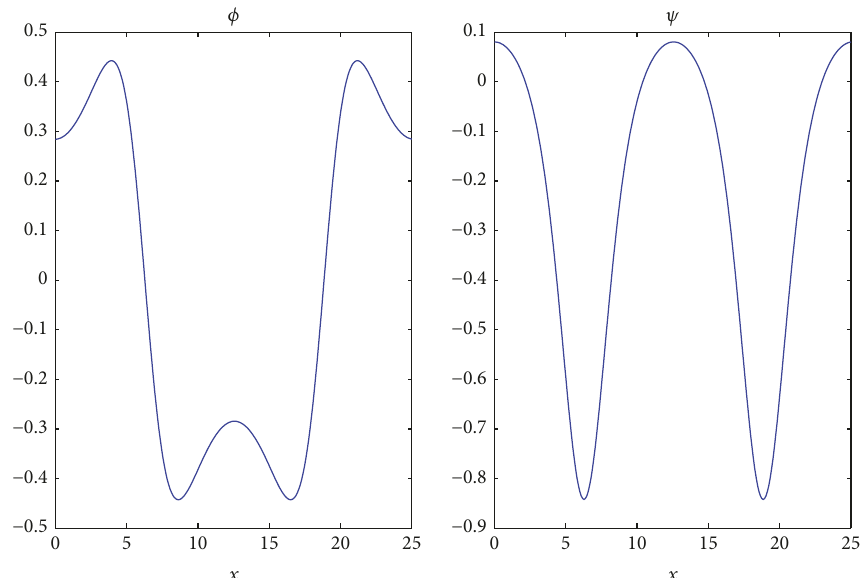
Figure 4: Approximations of the functions 𝜙, 𝜓 in the travelling wave solution (39) with 11 Newton’s iterations. The model’s parameters are 𝛼 = 𝛽 = 𝛾 = 1 , 𝑤 = 0.1 , and wave speed 𝑐 = 0.5 and the fundamental period is 𝐿 ≈ 25.13 .